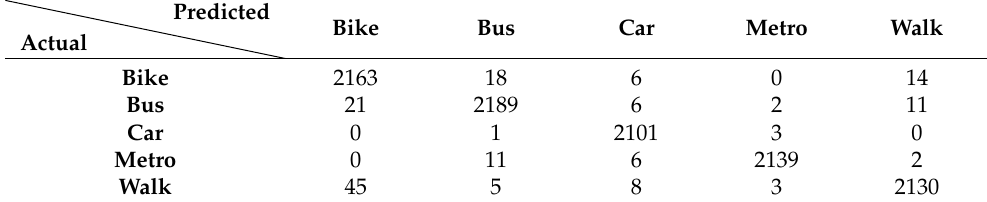
Table 4. The confusion matrix of the proposed